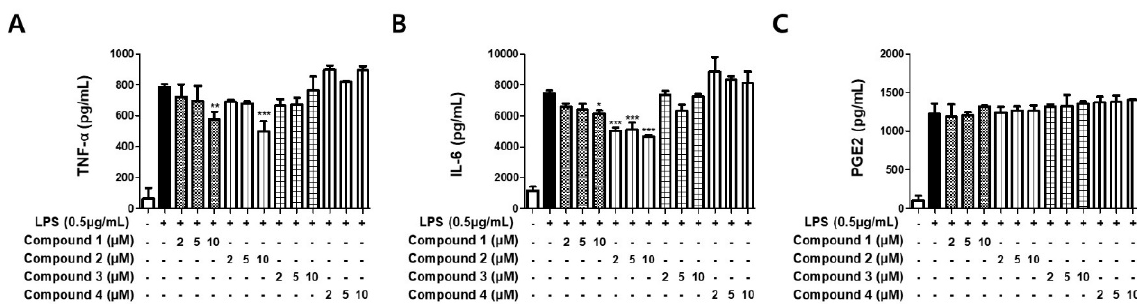
Figure 4. Effects of the isolated compounds on TNF- α ( A ), IL-6 ( B ), and PGE 2 ( C ) in LPS-stimulated BV2 cells. Cells were pretreated for 3 h with indicated concentrations of compounds 1–4 and stimulated for 24 h with LPS (0.5 µ g/mL). Bars represent means ± standard deviation of three independent experiments. * p < 0.05, ** p < 0.01, *** p < 0.001 compared with LPS-treated group.